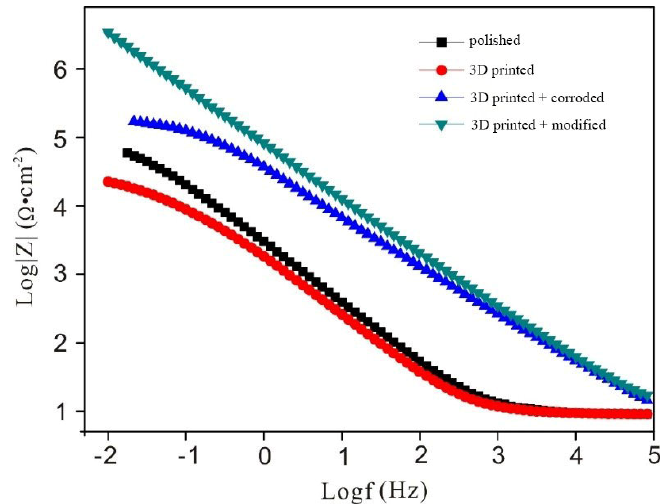
Figure 9. Bode diagrams of different samples.